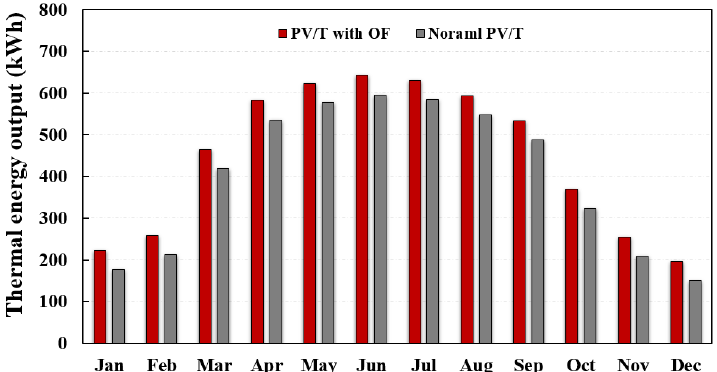
Figure 7. Thermal energy output.